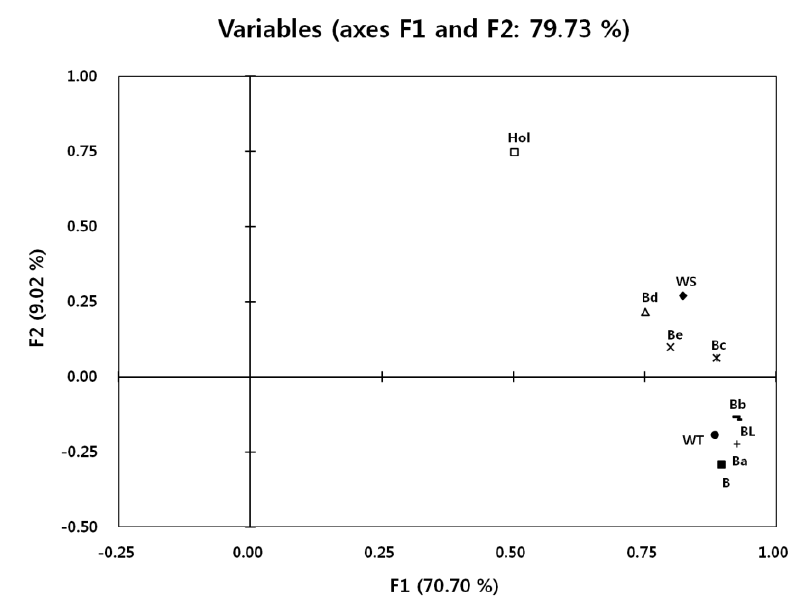
Figure 4. Principal component coordinates plot of each group based on correlations of allele frequencies for 22 microsatellite markers. WT = White coat mixed with brown, BL = Black coat mixed with brown, WS = White spotted coat separated with brown, B = Hanwoo cattle with a cuticolor nose and pure brown coat, B (a to e): a-e represent different degree of nose pigmentation with “a” being the lightest and “e” the darkest, Hol: = Holstein animals utilized as dairy cattle in